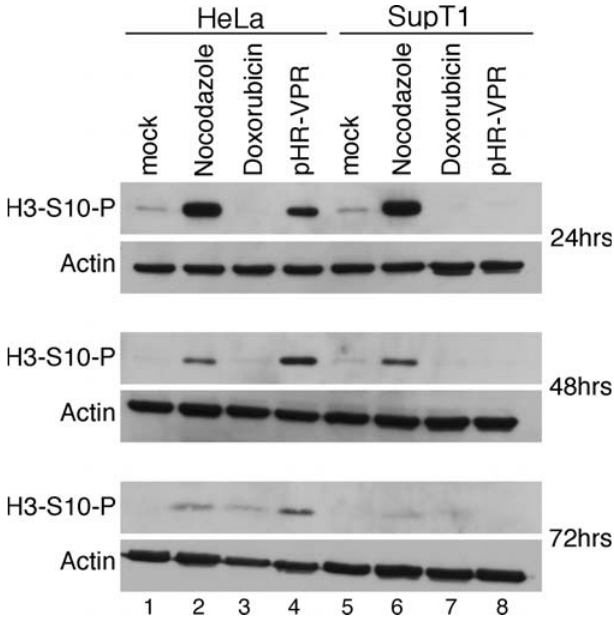
Figure 5. Vpr Induces Histone 3 Phosphorylation in HeLa but Not in SupT1 Cells HeLa or Supt1 cells were transduced with pHR-VPR-G and at indicated time points, lysed, and analyzed by Western blot with a phospho-specific antibody that recognizes phosphorylation of H3 at serine-10. Nocodazole (250 ng/ml) and doxorubicin (1 l M) were used as positive and negative controls, respectively.